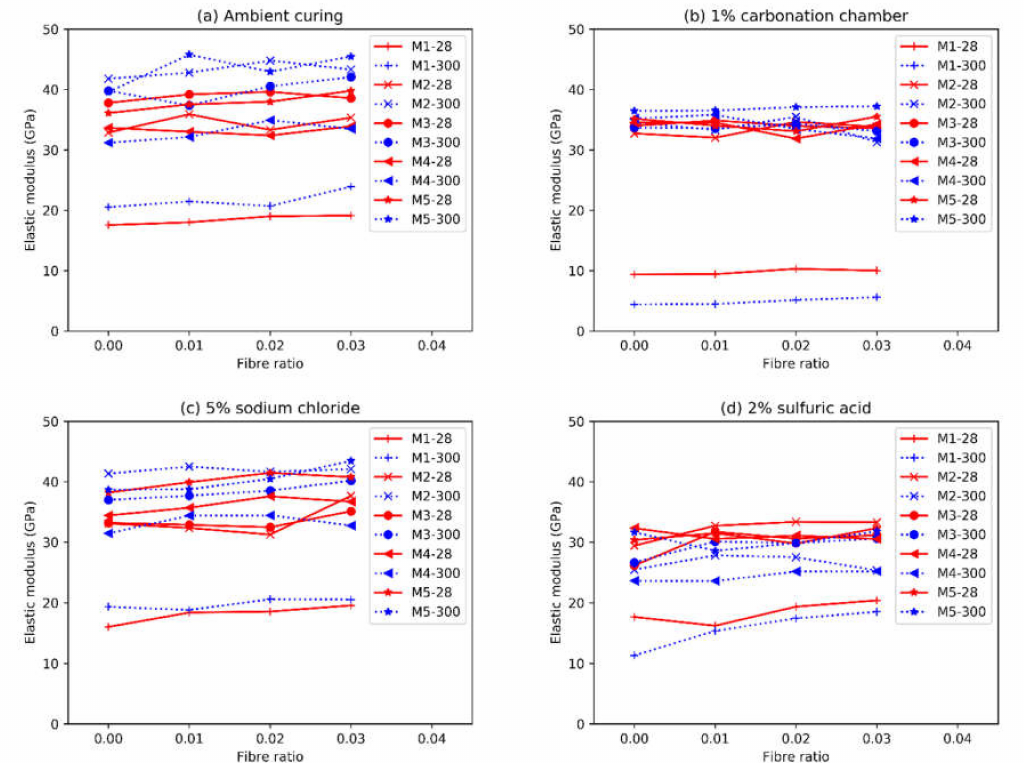
Figure 6. The elastic moduli of the specimens at 28 and 300 days in ( a ) ambient curing room, ( b ) carbonation chamber, ( c ) open-air sodium chloride baths, and ( d ) sulfuric acid baths.